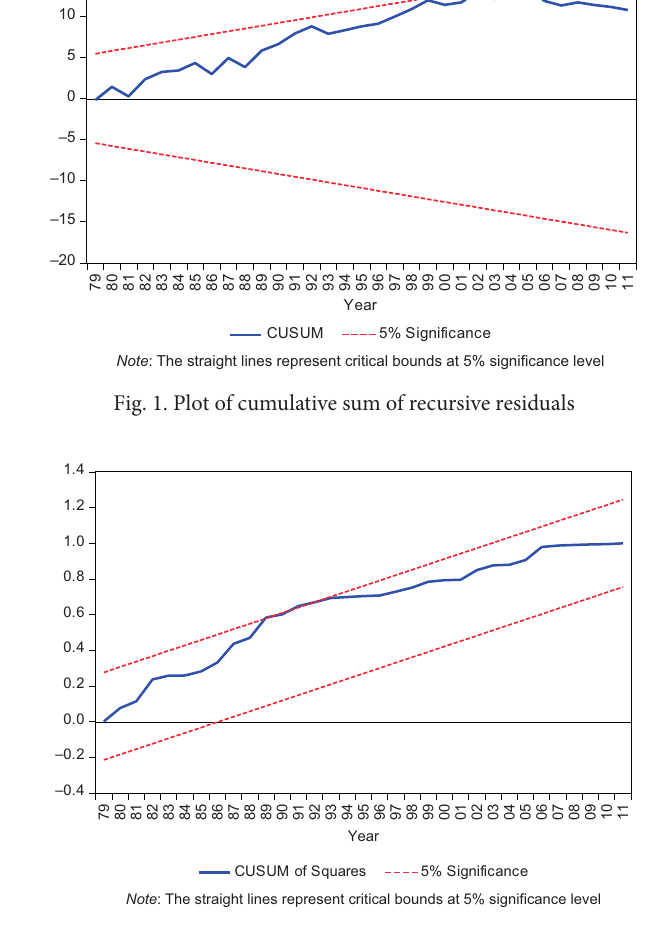
Fig. 2. Plot of cumulative sum of squares of recursive